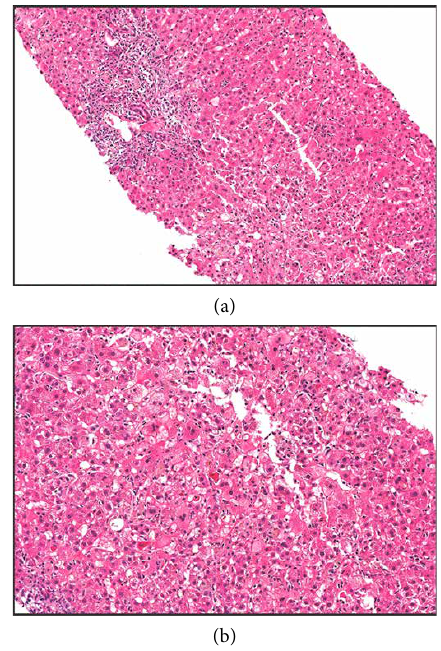
(a) Figure 1: Acute cholestatic hepatitis. (a) Portal inflammation with bile ductular reaction and periportal hepatocyte injury (H&E 100X). (b) Lobular disarray characterized by lobular inflammation, acidophil bodies, and cholestasis (H&E 200X).